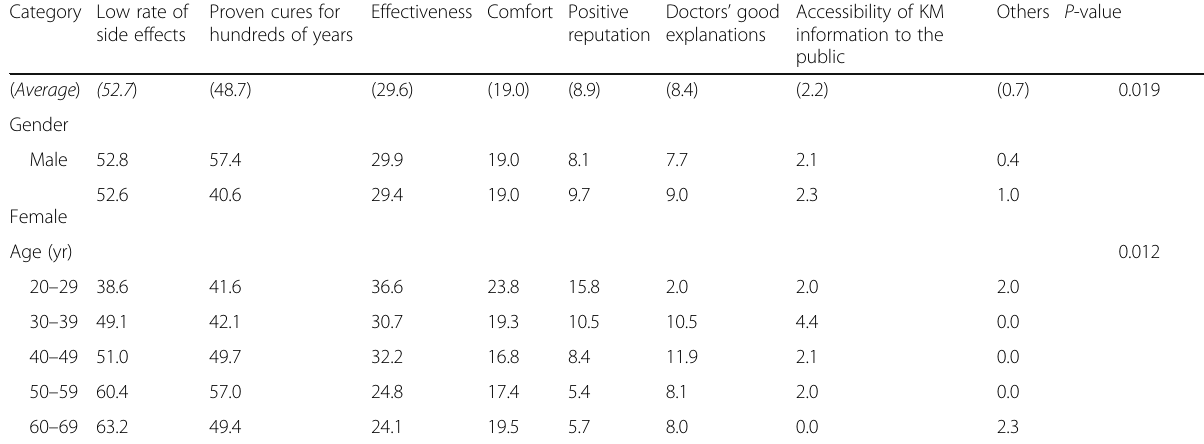
Table 3 Reasons for trusting KM therapies in 2014